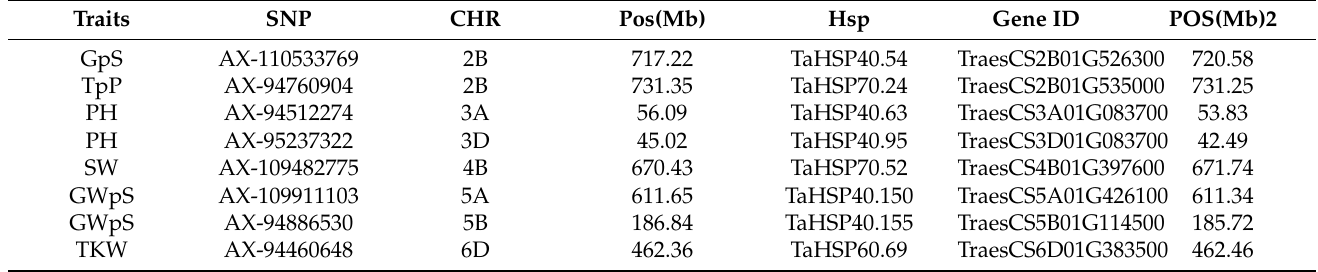
Table 4. QTNs associated with heat stress conditions and in proximity to heat shock proteins, with chromosome number, position (Mb), and position of closest